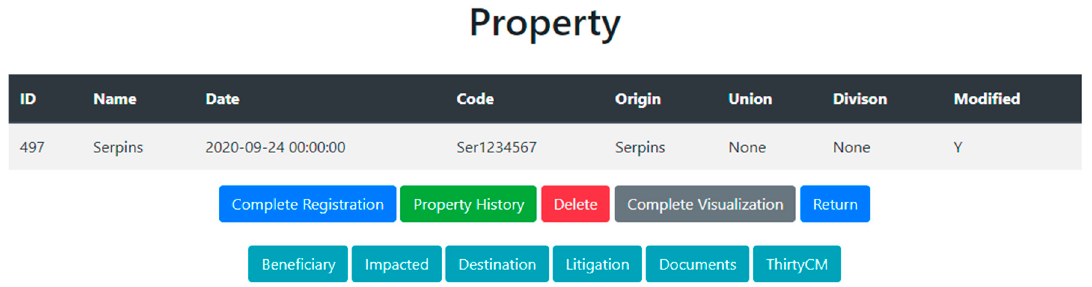
Figure 6. Property “Serpins” (ID = 497).